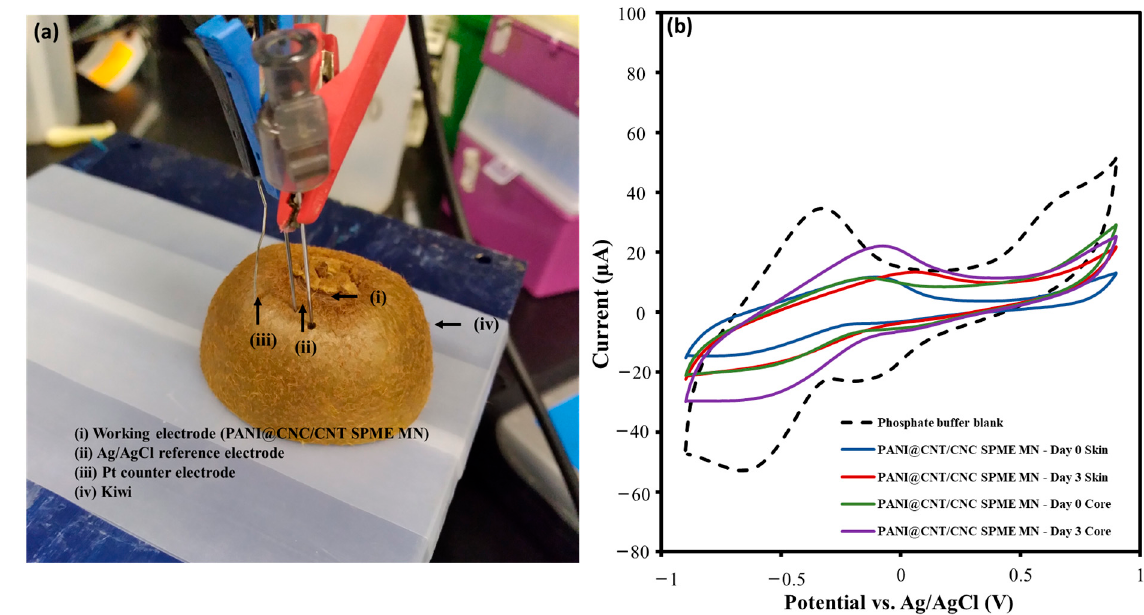
Figure 8. ( a ) Camera image of the experimental setup for in situ electrochemical kiwi analysis; ( b ) Overlaid CVs obtained from analysis of 0.10 M phosphate buffer blank, fresh (0-day), and 3-day ripened kiwi fruit skin and core using the PANI@CNT/CNC SPME MN.